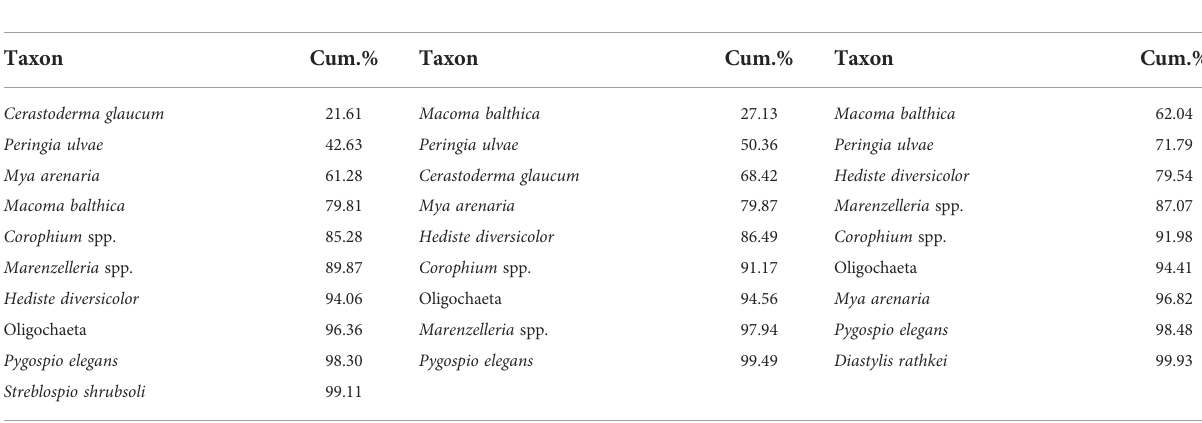
TABLE 2 The cumulative percentage similarity (Bray-Curtis) of taxonomic composition and biomass ( √ transformed) at three sampling stations. MW1 (73.85% of